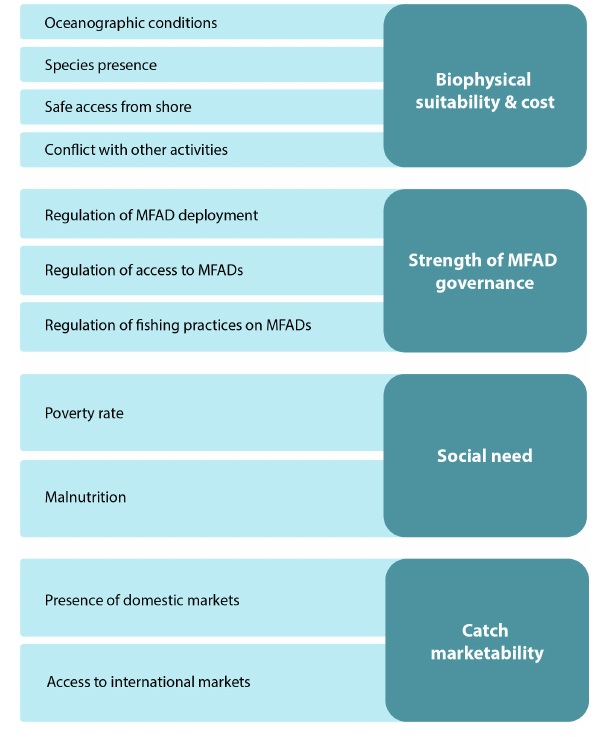
FIGURE 1 | Framework schematic. For details on specific variables and data sources used to evaluate each metric, see Supplementary Table 1